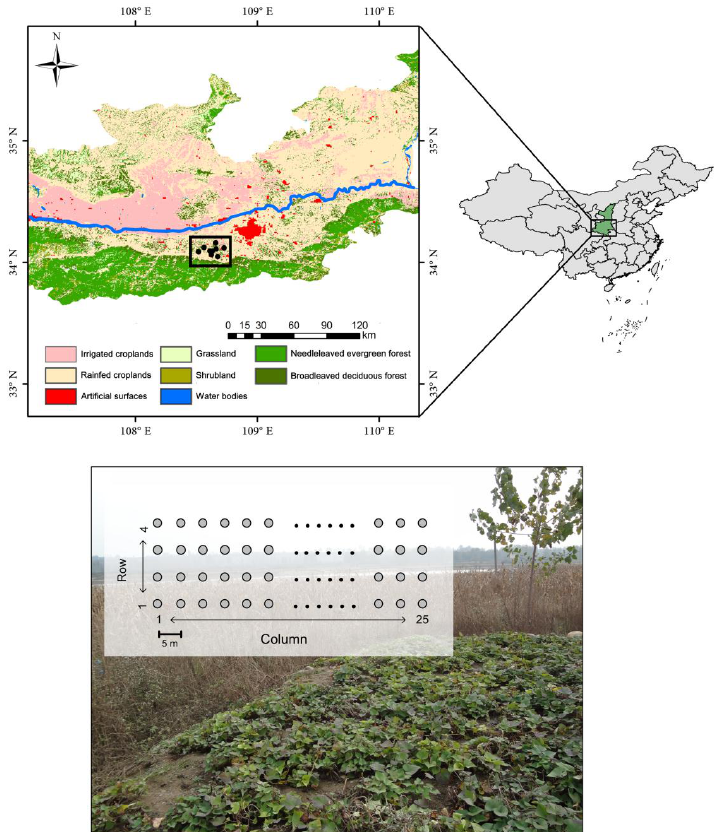
Figure 1. Land cover map of the Weihe Plain, Shaanxi Province, Central China. The black box indicates the study area, Hu County. We obtained this land cover data from GlobCover 2009 v2.3 (ESA Globcover Project; http://due.esrin.esa.int/globcover/). The black circles represent rodent sampling sites. Characteristics of the landscape in Hu County trapping web. Photo courtesy of P. Yu. Schematic representation of the rodent-trapping site. Traps were spaced at ~5-m intervals.